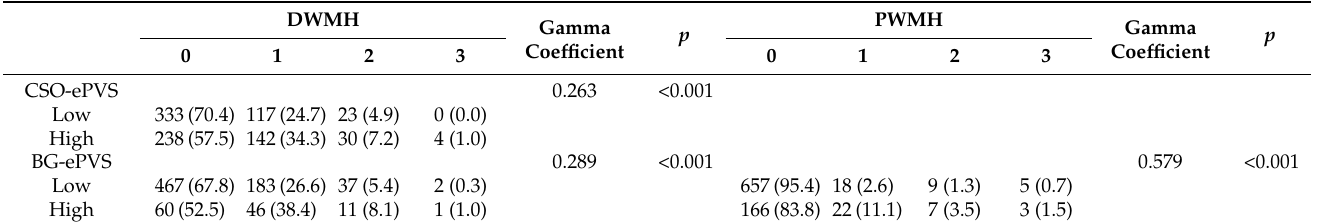
Table 7. Gamma coefficient analysis of the severity of ePVS and WMH